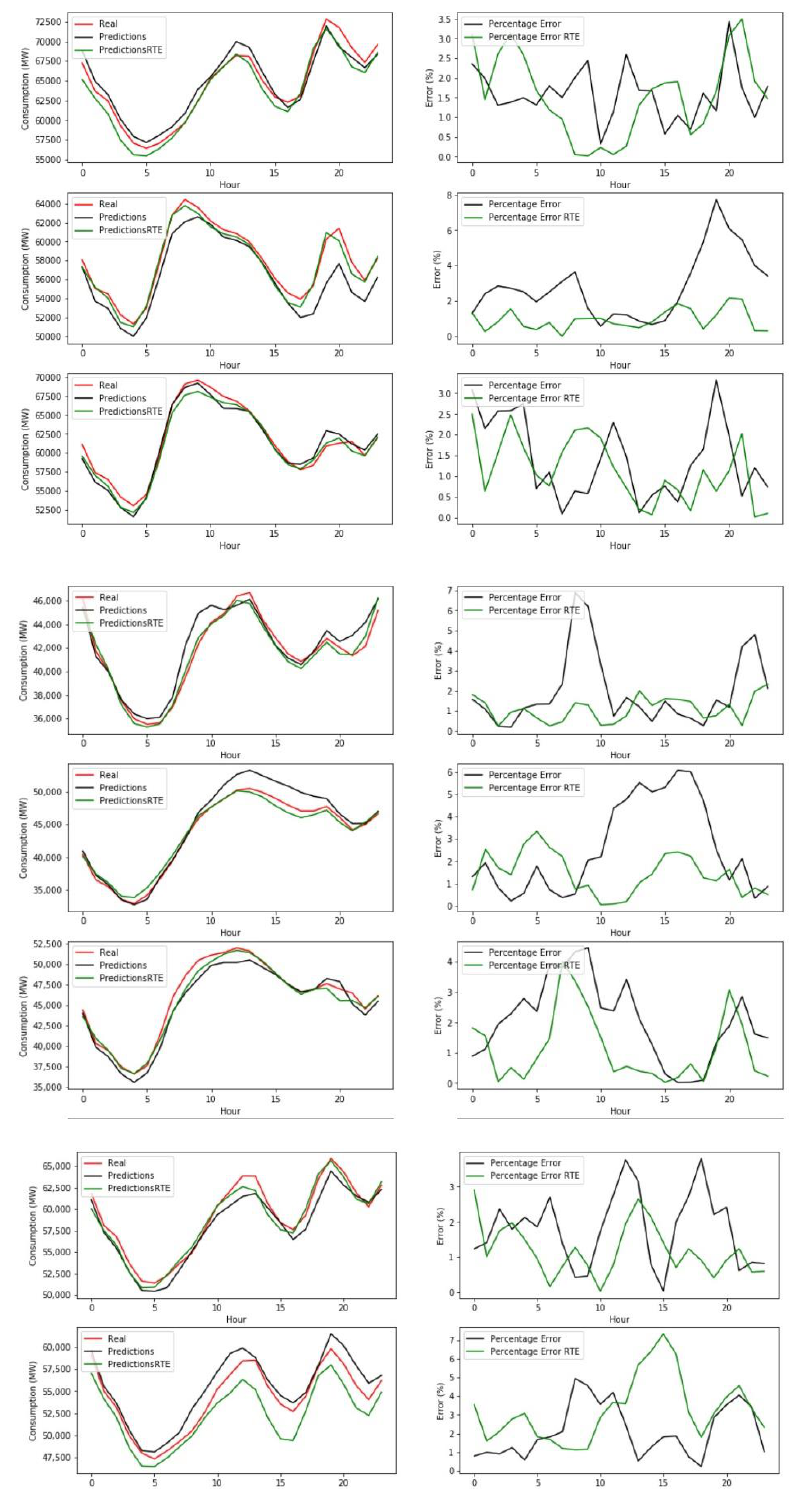
Figure 10. Performance of the forecast provided by the proposed deep neural network on the eight full days extracted from the original data. ( Left column ) Real energy consumption, neural network energy prediction and energy prediction by RTE model on a different full day in the Testing Set. ( Right column ) Absolute Percentage Error in energy prediction throughout the day by the neural network and the model proposed by